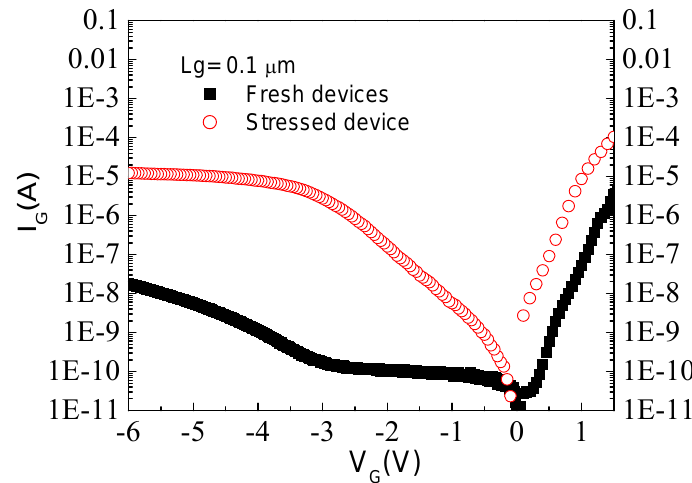
Figure 5. Gate current versus voltage before and after high reverse gate bias step stress for AlGaN/GaN